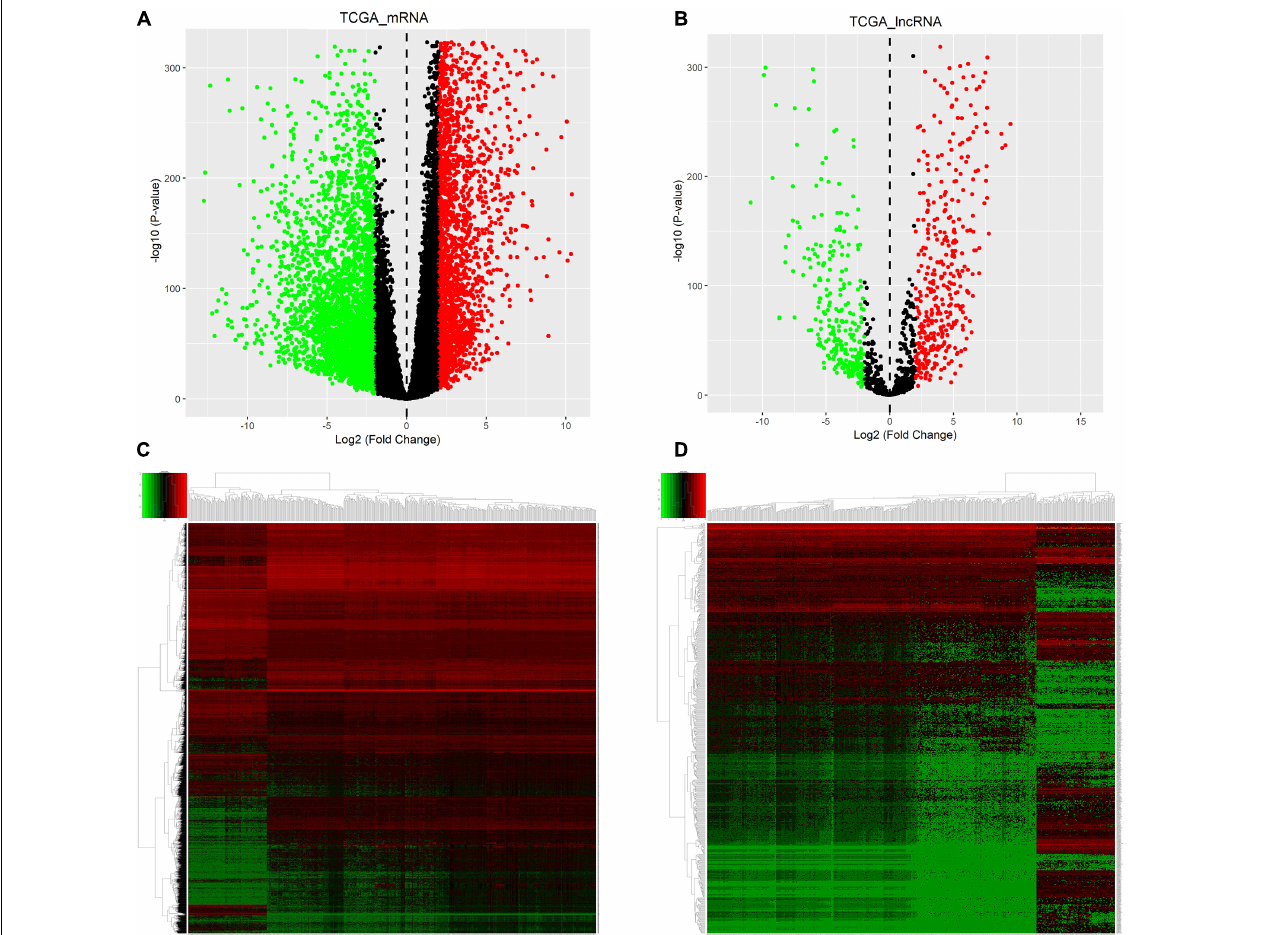
FIGURE 2 | Identification of DEmRNAs and DElncRNAs for ALL. Volcano plot showing DEmRNAs (A) and DElncRNAs (B) for ALL. As shown in heatmaps, the differences in expression patterns of DEmRNAs (C) and DElncRNAs (D) between ALL bone marrow samples and normal samples. Red represents upregulation and green represents downregulation. DEmRNAs: differentially expressed mRNAs; DElncRNAs: Differentially expressed lncRNAs; ALL, Acute lymphoblastic